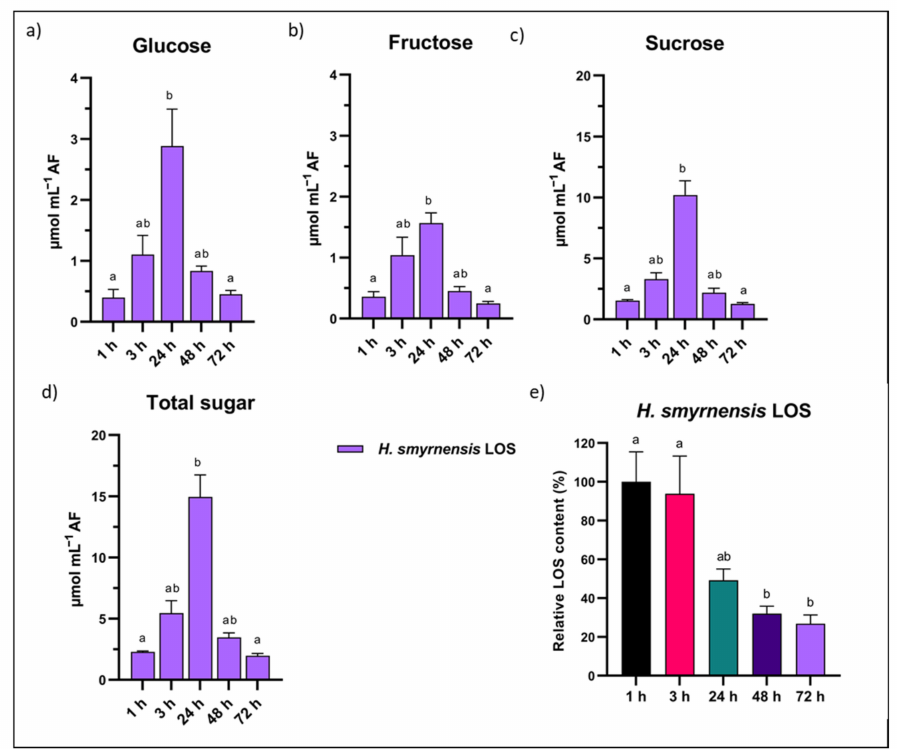
Figure 9. Apoplastic dynamics after LOS priming in rocket leaves. Apoplastic fluid (AF) was extracted from rocket leaves at different time points after LOS priming. Apoplastic ( a ) Glc ( b ) Fru and ( c ) Suc were measured on HPAEC-IPAD and ( d ) total sugar levels were calculated. ( e ) LOS profiles were analyzed on HPAEC-IPAD after LOS priming. Bars represent the mean ± SEM. A minimum of 6 biological replicates was used per treatment. The experiment was repeated 2 times with consistent results. Letters indicate significant differences between time points ( p <